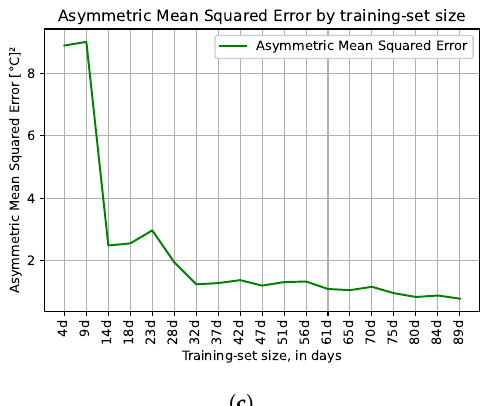
Figure 7. Variation of the errormetrics by increasing the data size used for the training phase. ( a ) represents the Mean Squared Error, ( b ) the Root Mean Squared Error and ( c ) the Asymmetric Mean Squared Error, defined in Section 3.3. On the x -axis, the number of days of data considered for the training. One month is sufficient to build a robust model, while more time brings no significant improvement.